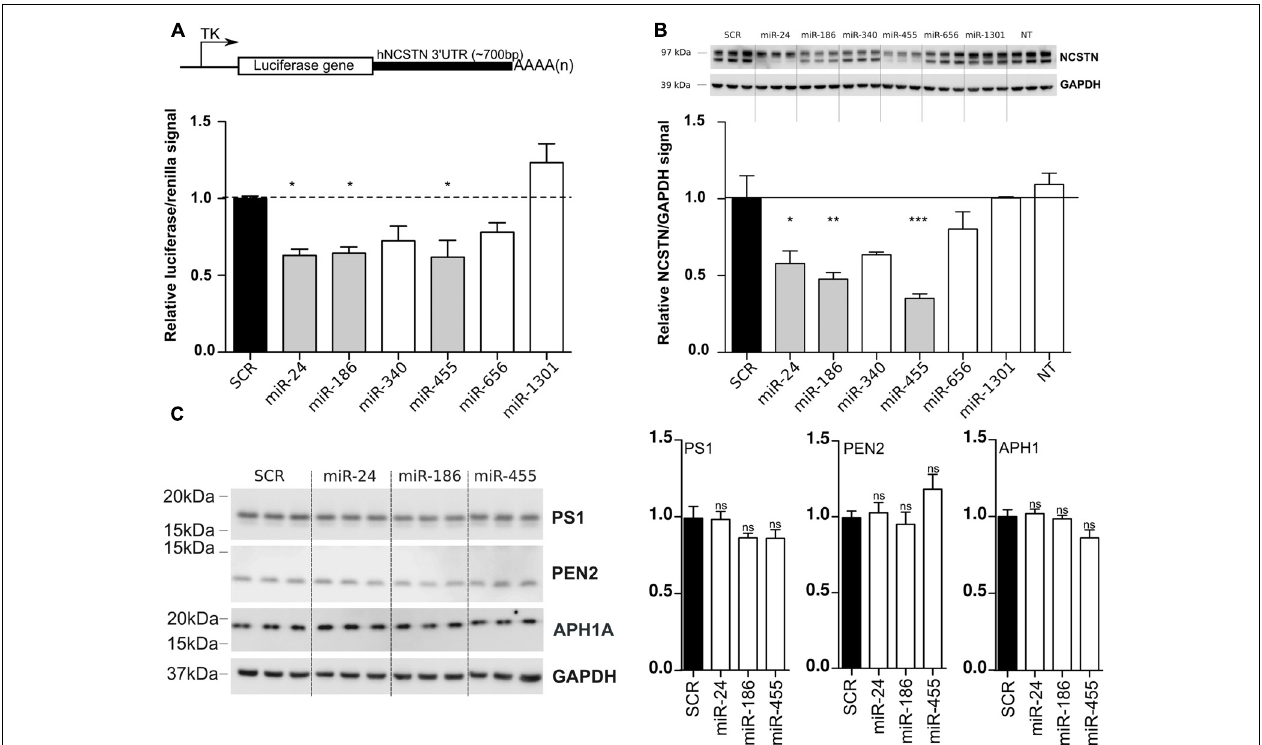
FIGURE 1 | In vitro functional analysis of NCSTN targeting miRNAs. (A) Schematic representation (not to scale) of the luciferase reporter construct used in this study (upper panel). TK; thymidine kinase promoter, AAAA(n); PolyA site, HeLa cells were transfected with 50 nM pre-miRs (as indicated) as well as a reporter construct containing the untranslated region (3 (cid:2) UTR) of hNCSTN . The cells were lyzed 24 h post-transfection and luciferase signal was measured. Signals were normalization for transfection efficiency and graph represents the luciferase signals compared to the scrambled control (SCR). Statistical significance was assessed by one-way ANOVA with Bonferroni post-hoc test. * p < 0.05. (B) HeLa cells were transfected with 50 nM pre-miRNAs (as indicated). The cells were lyzed